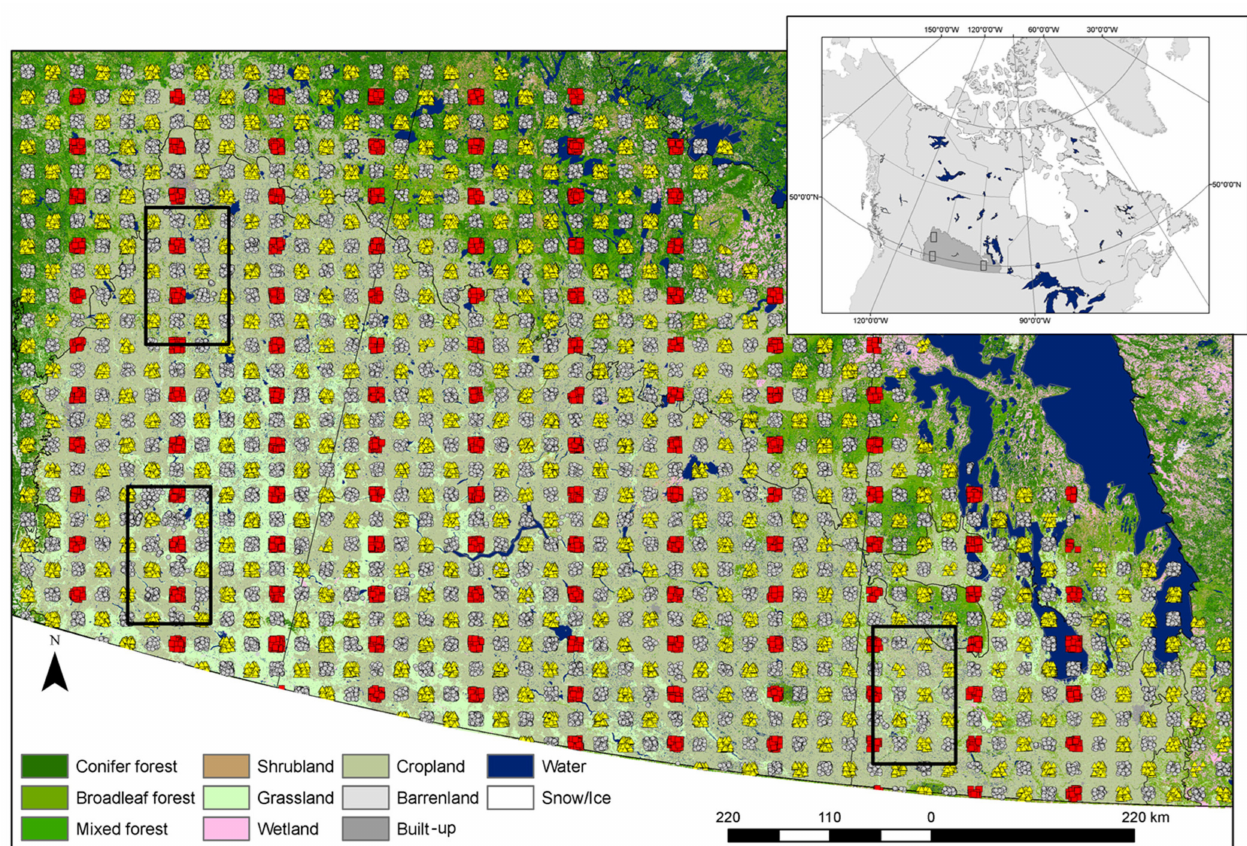
Figure 2. Samples used for classifier training and assessment. Grey circles were used for training, yellow triangles were used for deep-learning model convergence, and red squares were used for independent accuracy assessment. Black outlines identify the areas used for change assessment. The land-cover map is the 2010 land cover of Canada